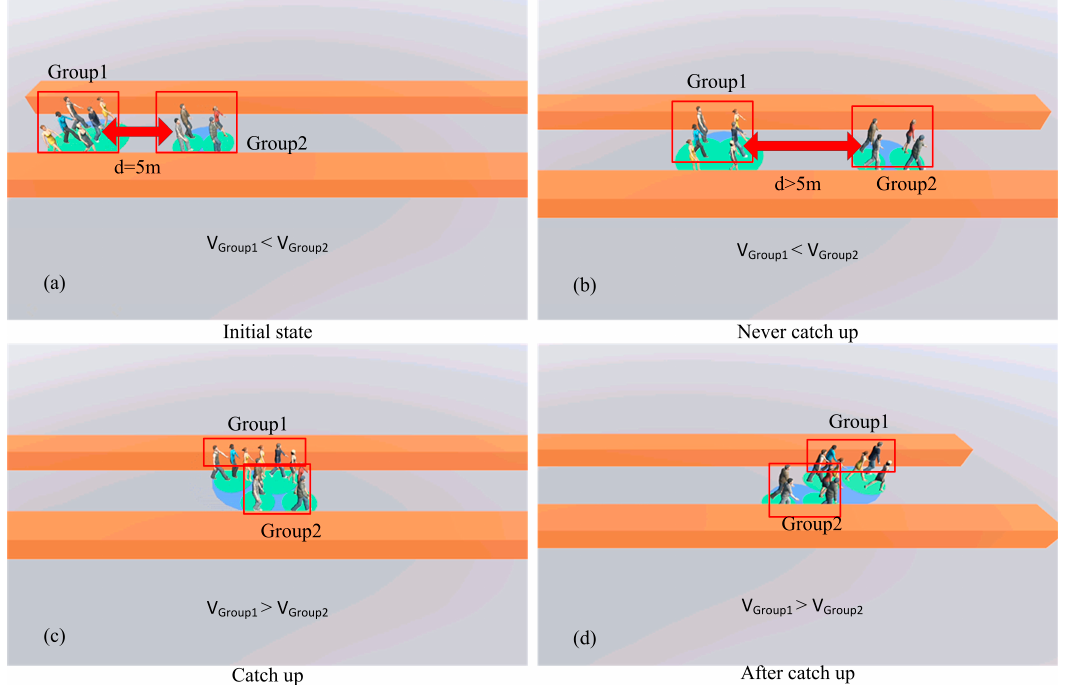
Figure 7. Process of catch-up avoidance. ( a ) Initial state of two groups with 5 m spacing. ( b ) Group 1 will never catch up Group 2 if Group 2 is faster. ( c ) If Group 1 is faster than Group 2, Group 1 will take the initiative to adjust its structure to exceed Group 2. ( d ) After overtaking, both groups will restore the structure prior to an evasion.